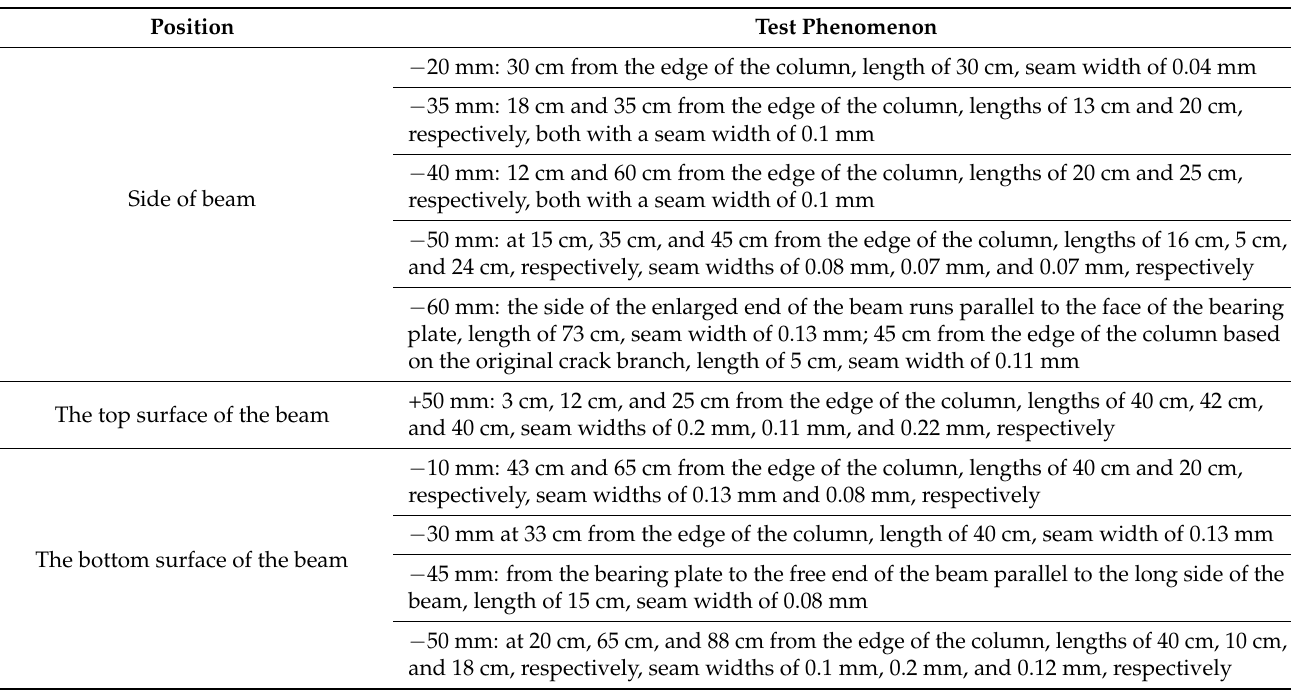
Table 7. Specimen J1 test